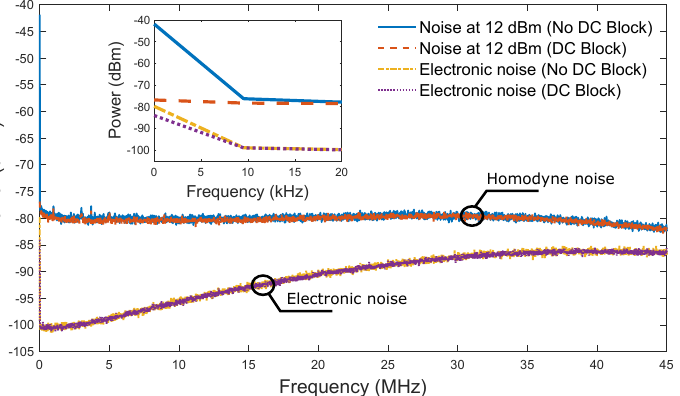
Figure 3. The power spectral density (PSD) when the LO is on (upper lines) and off (lower lines). Inset focus on low-frequency contributions. The introduction of the DC block suppresses the observed low frequency contributions, with no visible difference in the remaining spectral